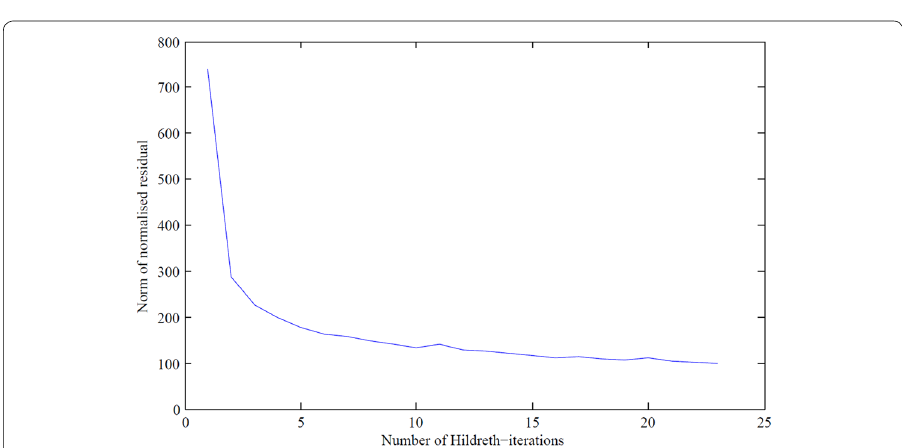
Fig. 8 This plot visualises the residual norms of the Hildreth iterations of the ACIM code, for the Eora problem. Each of the residual norms belongs to an iterate adhering to the boundary conditions